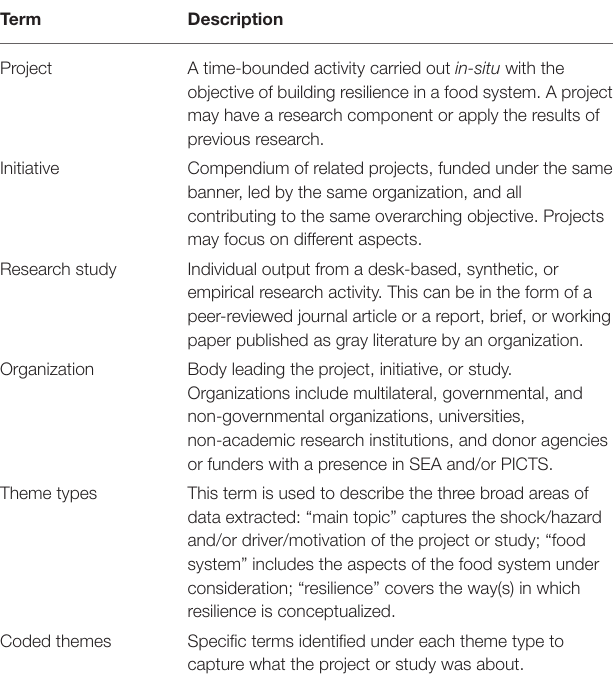
TABLE 1 | Descriptions of main terms used in the methods for the structured search, data extraction, and analysis.